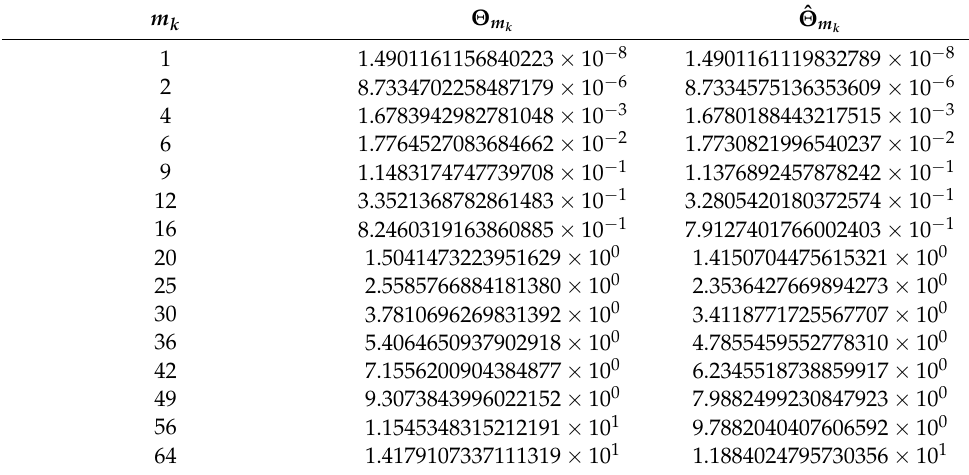
Table 3 collects the corresponding values of Θ m Table 3. Values of Θ m and ˆ Θ m , m k ∈ M , for the forward absolute and relative errors, E af ( P m k k ( A )) , of the exponential and E rf ( P m k